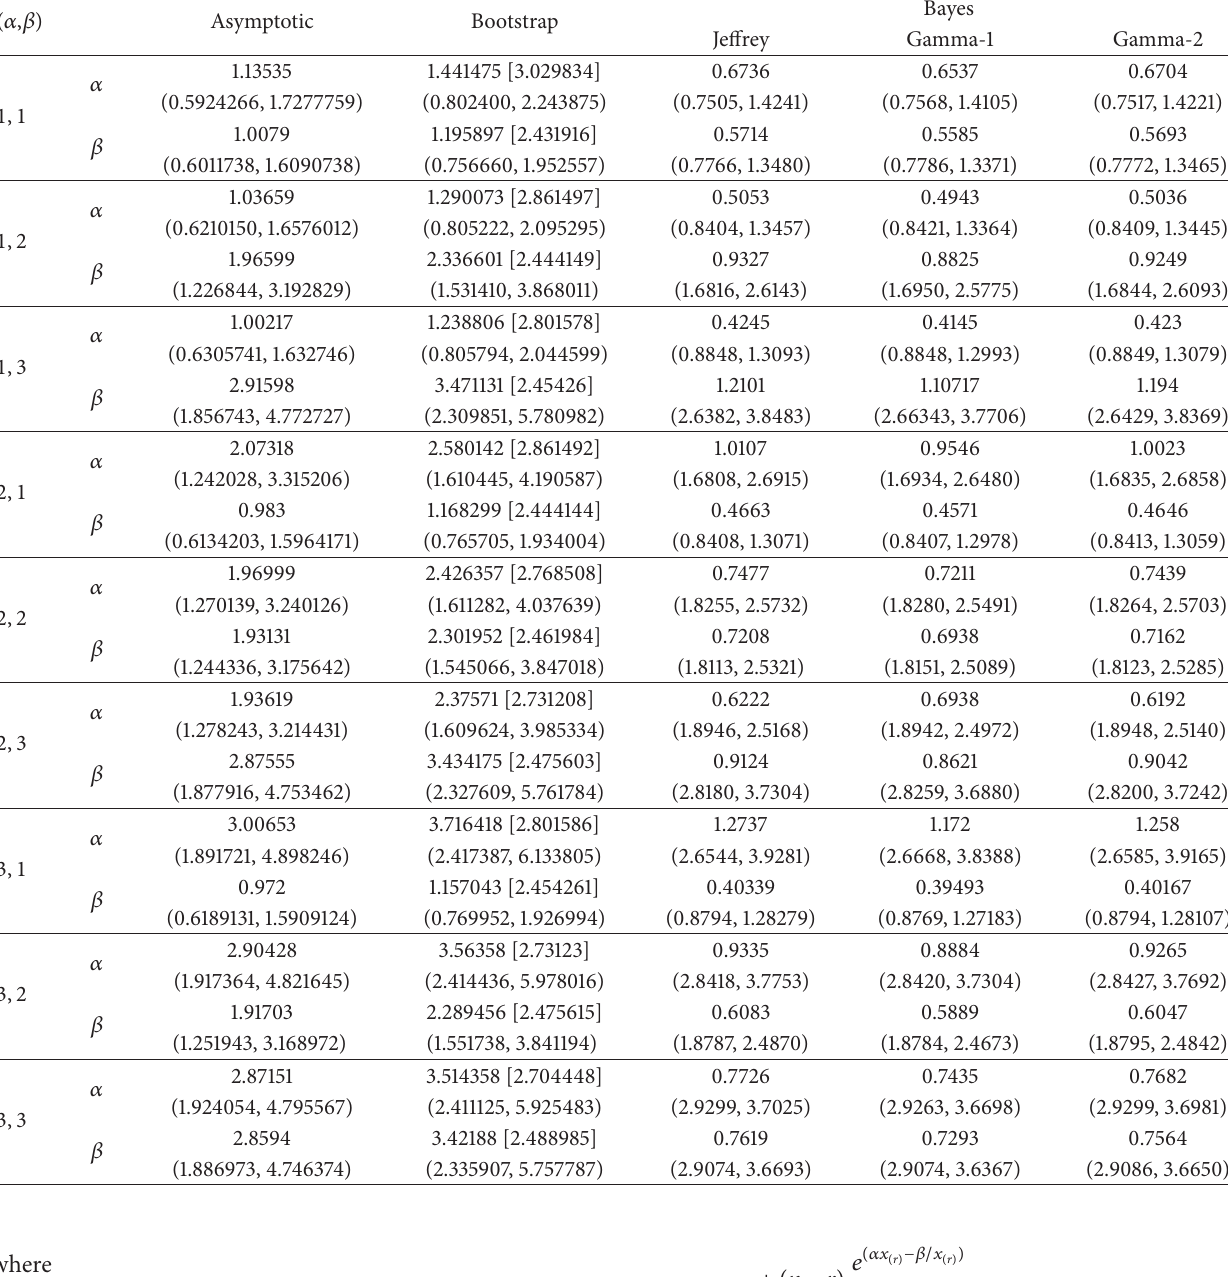
Table 7: Average 95% confidence/HPD intervals (in brackets) and bootstrap method along with their width and shape (in square brackets) for bootstrap method for complete sample 𝑛 = 20 , 𝑟 = 16 with varying